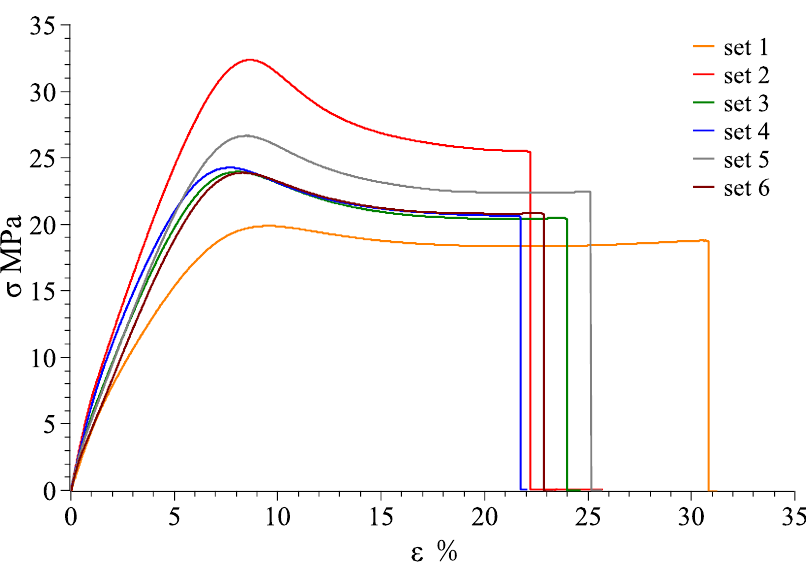
Figure A5. D8520, D8530 stress–strain curve for the Y-axis (6 specimens).